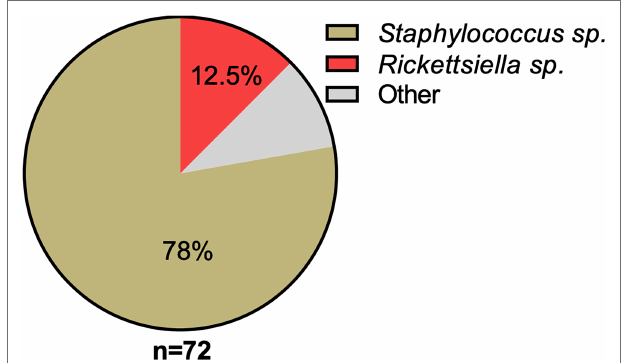
FIGURE 1 | Classification and relative abundance of bacteria associated with Dermanyssus gallinae eggs. The presence of bacterial DNA in mite eggs was verified by PCR using universal bacterial 16S rRNA gene primers. We generated a total of 72 16S rRNA reads from DNA isolated from surface- sterilized D. gallinae eggs. Amplicons were sequenced ( n = 72) and classified with the RDP Classifier 2.13 (training set No. 18). Sequences with <80% bootstrap support as their genus assignment were removed from the dataset. Classifications are as indicated in the legend, other (gray) represents single hits ( n = 1) to the following genera: Blautia , Clostridium , Devosia , Paenalcaligenes , Salinicoccus , Streptococcus , and Tsukamurella